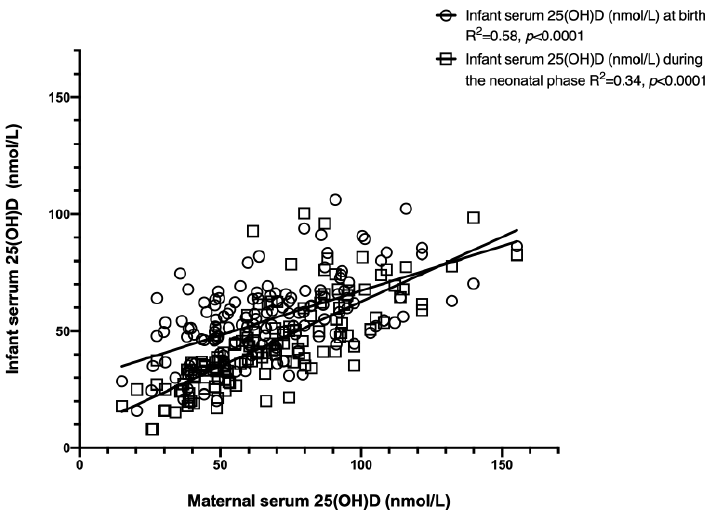
Figure 2. Maternal 25(OH)D concentration as a correlate of vitamin D status of neonates at birth and 1 month of age. Linear regression of infant birth (7.9–100.4 nmol/L, n = 142) and neonatal (15.9–106.2 nmol/L, n = 142) serum 25(OH)D concentrations on maternal (15.0–155.3 nmol/L, n = 142) serum 25(OH)D concentrations. The data were analyzed using a mixed linear model ( p < 0.05). Abbreviations: 25(OH)D: 25-hydroxyvitamin D.